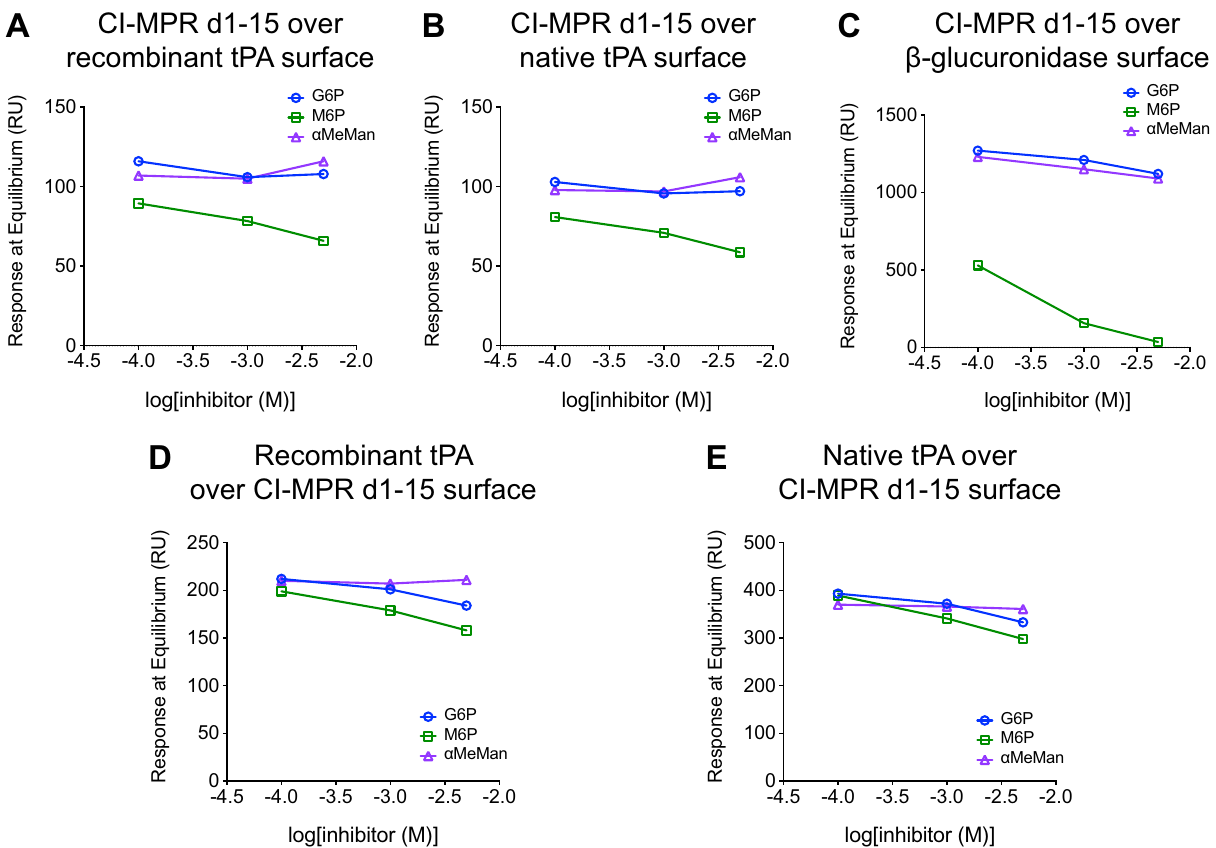
Figure 3. The interaction between CI-MPR and tPA is partially inhibited by M6P in a dose-dependent manner. ( A – C ) Bovine CI-MPR d1–15 at 20 nM was incubated with small molecule inhibitors, M6P, G6P, and αMeMan, at increasing concentrations (0.1, 1.0, and 5.0 mM) and flowed over various sensor chip surfaces. The response at equilibrium is plotted with respect to the log of the inhibitor concentration. ( A ) Recombinant tPA was immobilized by amine coupling. ( B ) Native tPA was immobilized by amine coupling. ( C ) β-Glucuronidase was immobilized by amine coupling. ( D , E ) Human CI-MPR d1–15 was immobilized to a sensor chip by amine coupling. Incubated in the presence of small molecule inhibitors at increasing concentrations (0.1, 1.0, and 5.0 mM), 40 nM tPA was flowed over the CI-MPR surface: ( D ) recombinant tPA in the presence of M6P, G6P, and αMeMan; ( E ) native tPA in the presence of M6P, G6P, and αMeMan. CI-MPR d1–15 cation-independent mannose 6-phosphate receptor domains 1–15, tPA tissue plasminogen activator, M6P mannose 6-phosphate, G6P glucose 6-phosphate, αMeMan α-methyl